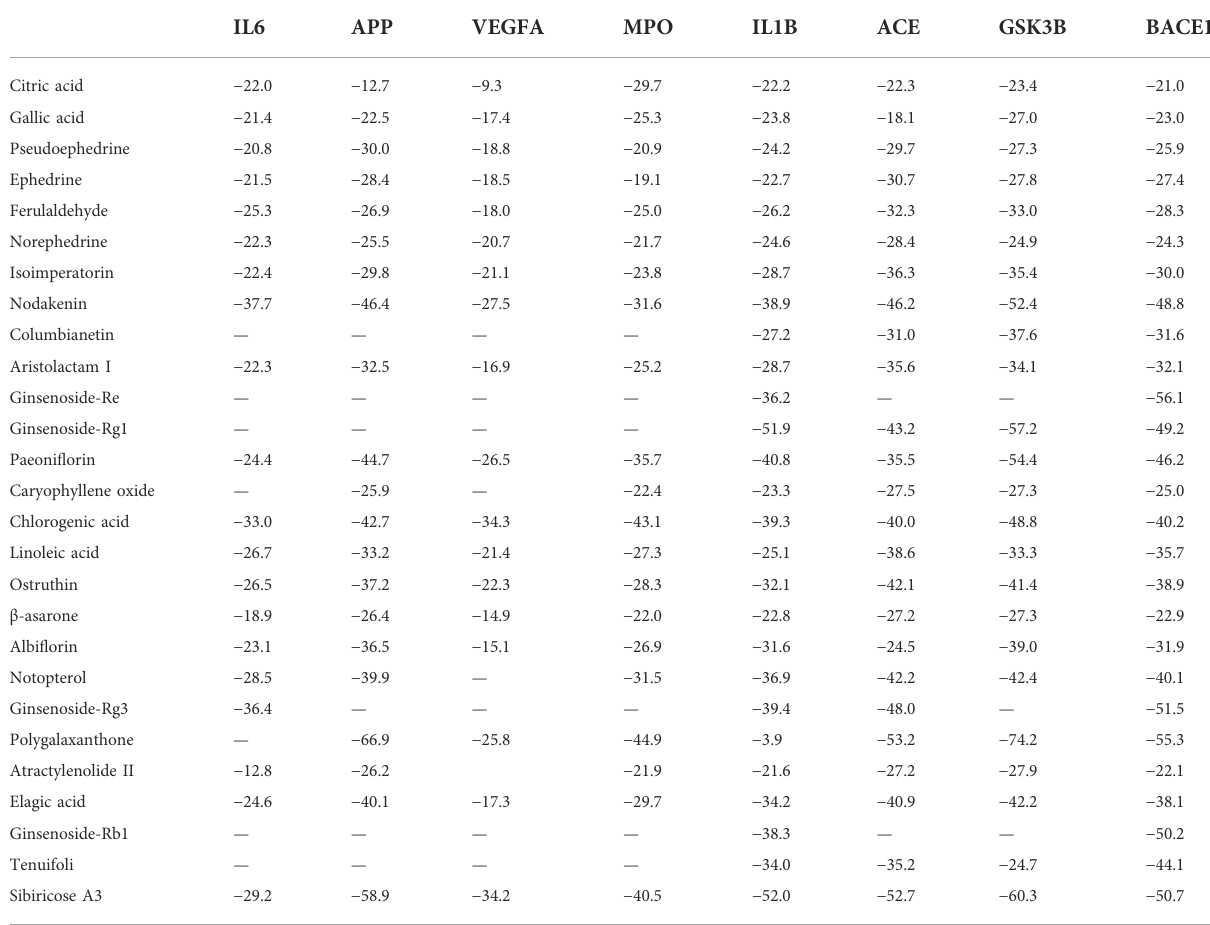
TABLE 6 The Glide energy information of 8 targets with 27 compounds of